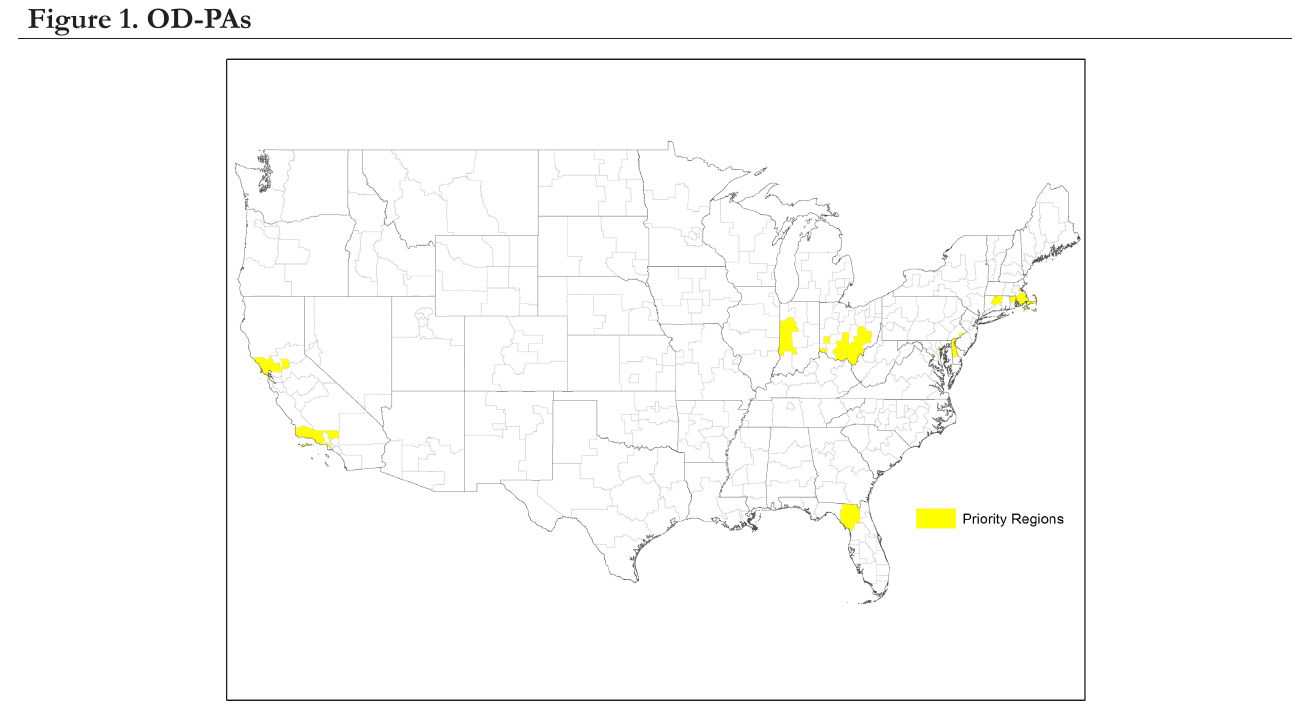
Figure 1. OD-PAs